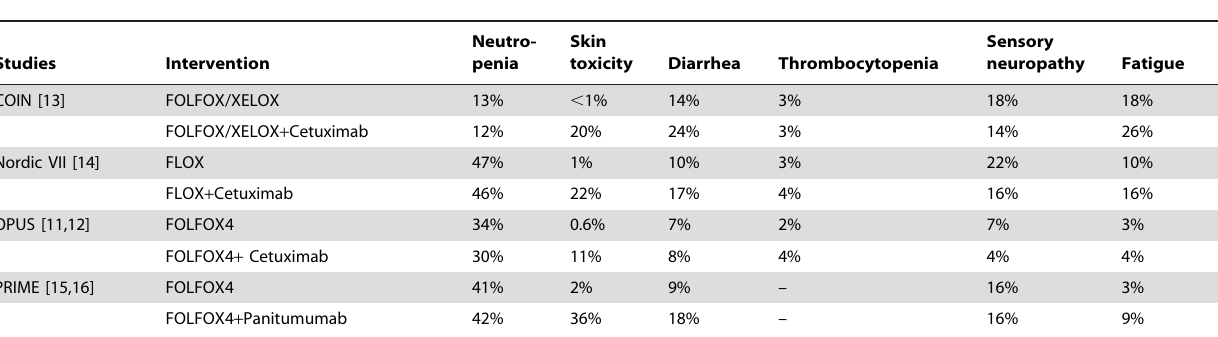
Table 2. Toxic effects recorded from randomized controlled trials (Grade 3–4 Adverse Events).